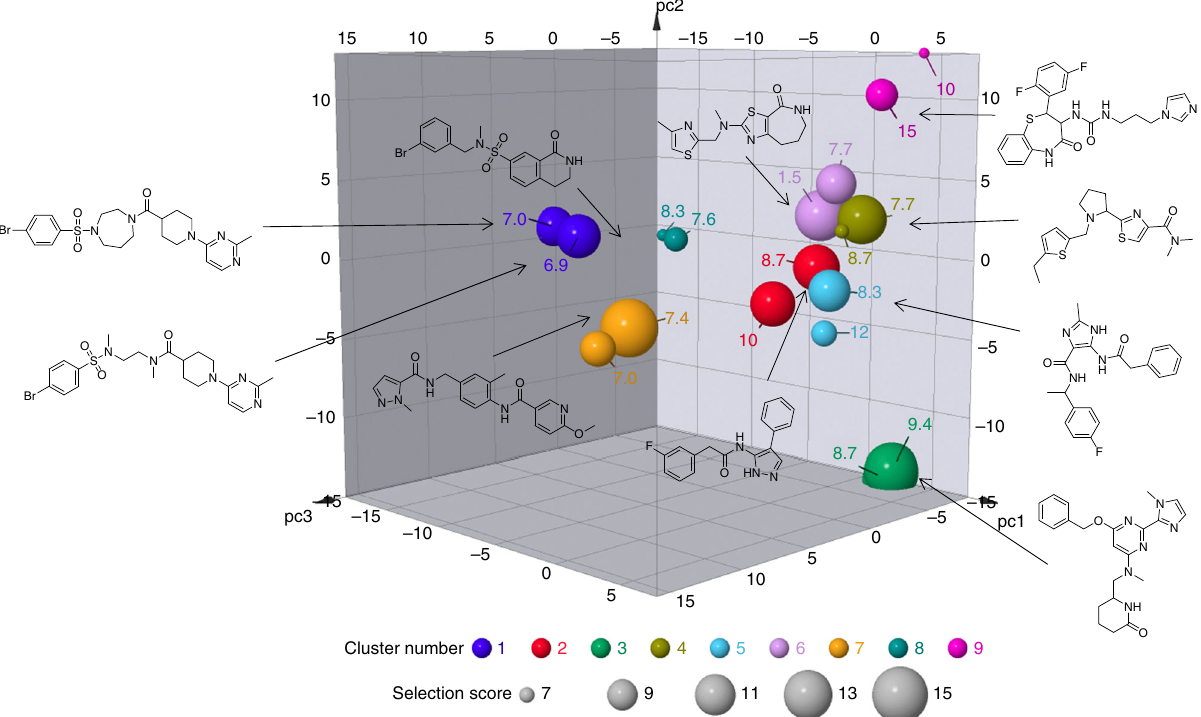
Fig. 3 Eighteen selected hits represented in chemical space. The fi rst three principal components (PC1 – 3) together account for 31.6% of the overall variance in the data set 39 . The chemotypes show clustering in chemical space. The size of each data point is proportional to the Selection Score. Selection Score is calculated by summation of the component scores using the criteria in Supplementary Table 3. The label for each point is the ligand ef fi ciency-dependent lipophilicity index (LELP) with values <10 considered good 28 . A selection of the best compound structures is shown (large spheres) in a 3D plot produced by Datawarrior 39 . The cluster number is indicated by colour: cluster 1 (dark blue sphere), 2 (red sphere), 3 (green sphere), 4 (dark gold sphere), 5 (light blue sphere), 6 (lilac sphere), 7 (orange sphere), 8 (teal sphere), 9 (pink